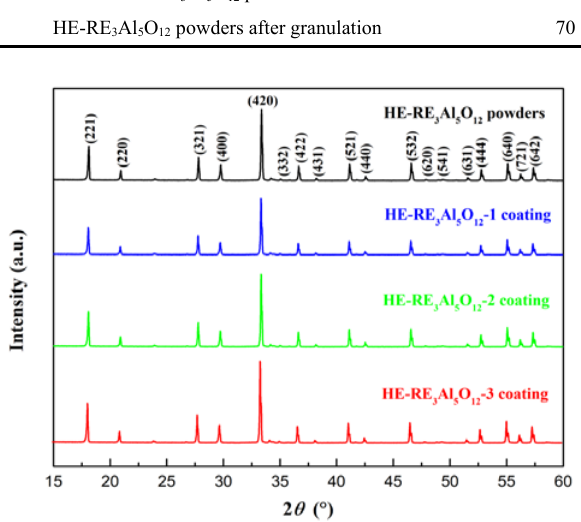
Fig. 5 XRD patterns of the micron-agglomerate spray powders and the as-sprayed coatings prepared by APS. melted and not fully spread, which is due to the close spraying distance, thus causing the unmelted spray powders to be deposited directly on the substrate surface. The distributions of the unmelted powders are improved by constantly adjusting the spraying